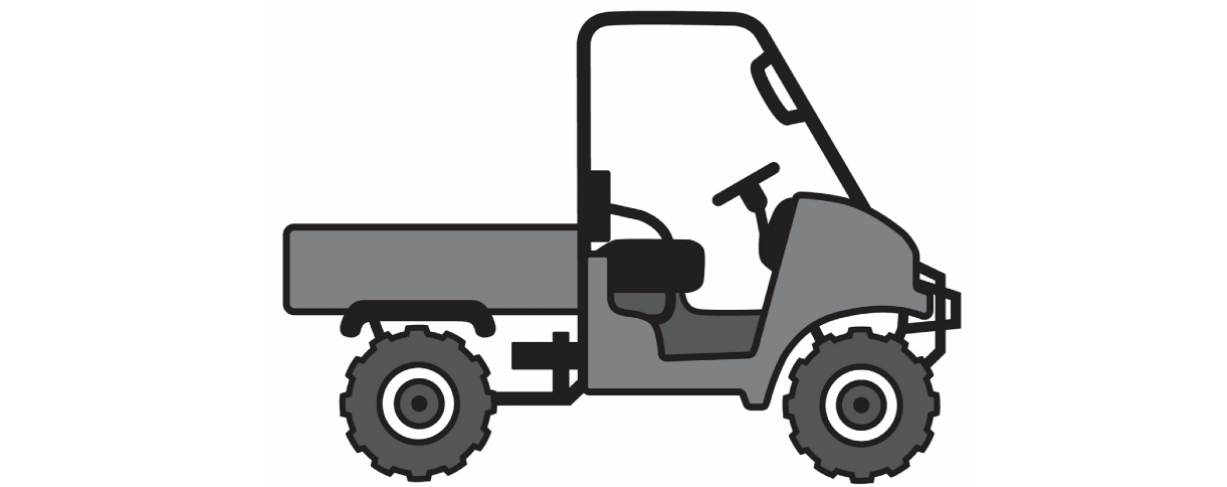
Figure 2. Recreational off-highway